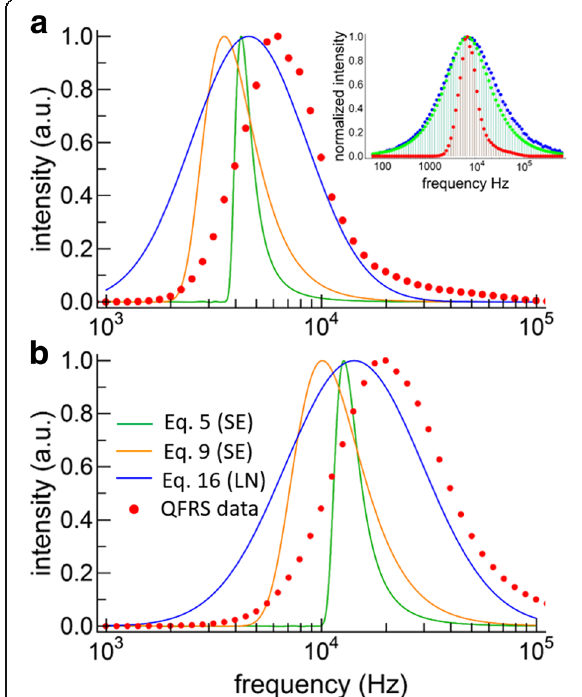
Fig. 6 Lifetime distributions. a Lifetime distributions for large SiNCs obtained from fitting the TRS data with the two SE models and the LN model. The deconvolved QFRS data is also shown (red points). The inset shows the raw QFRS data for this sample (blue), the response function (green), and the deconvolution (red). b Lifetime distributions obtained by model fitting the TRS data (lines, same color scheme for both graphs) and QFRS (red points) for the small